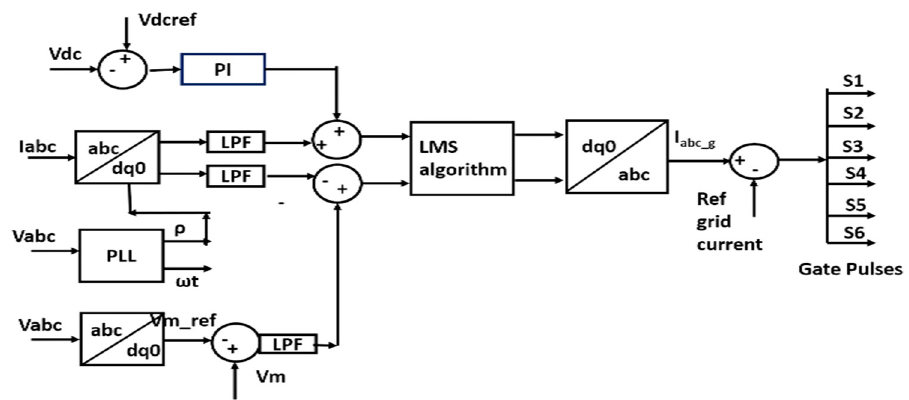
Figure 6. Synchronous reference frame theory for implementation of an adaptive LMS control law.